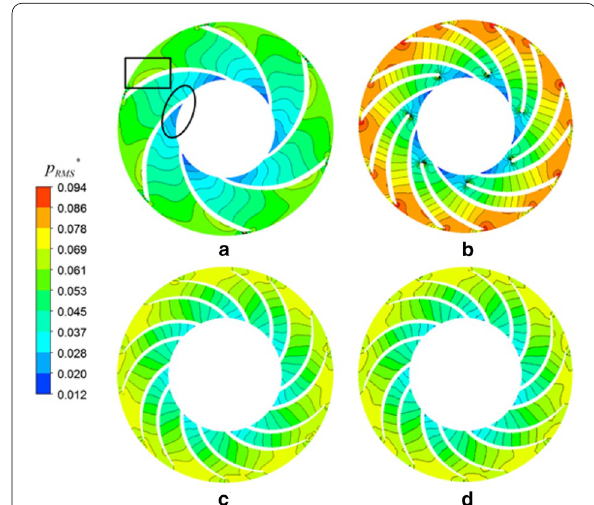
Figure 12 Contour of the dimensionless RMS pressure on the middle surface of the impeller for the four models: a model #1; b model #2; c model #3; d model